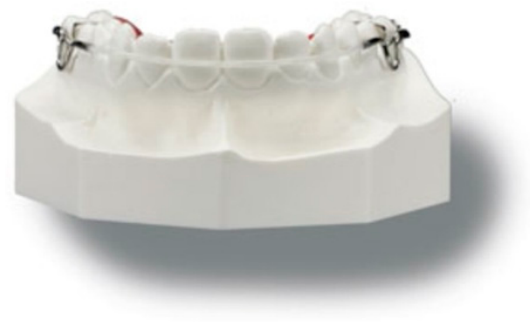
Figure 2. Astics translucent labial bow.